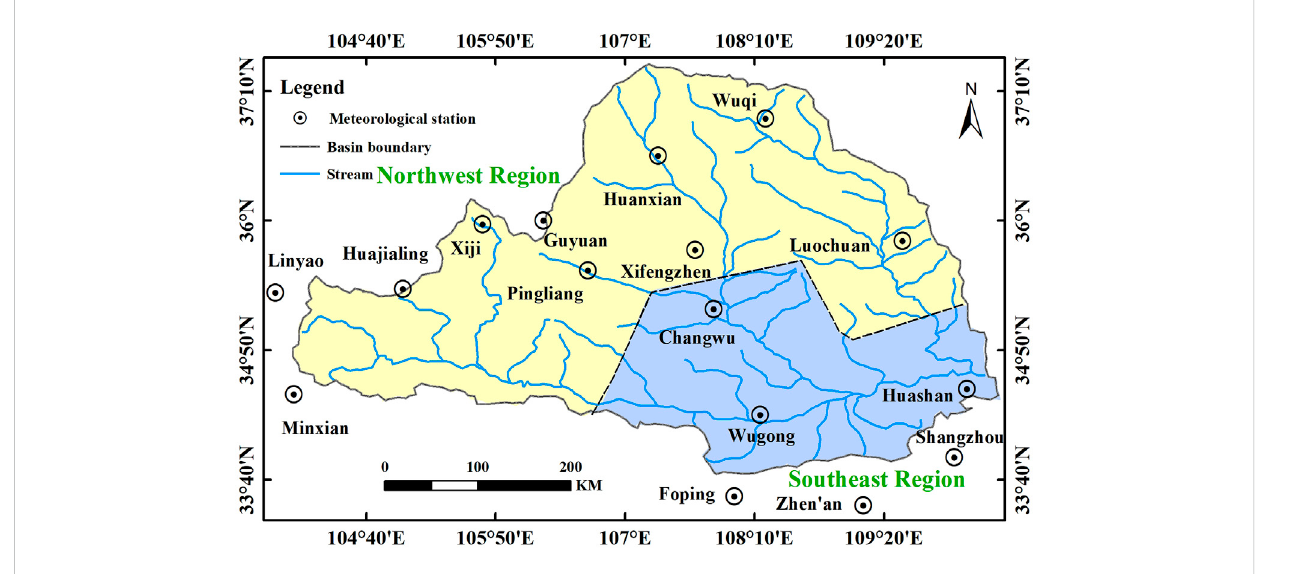
FIGURE 4 Spatial distribution of the meteorological stations.